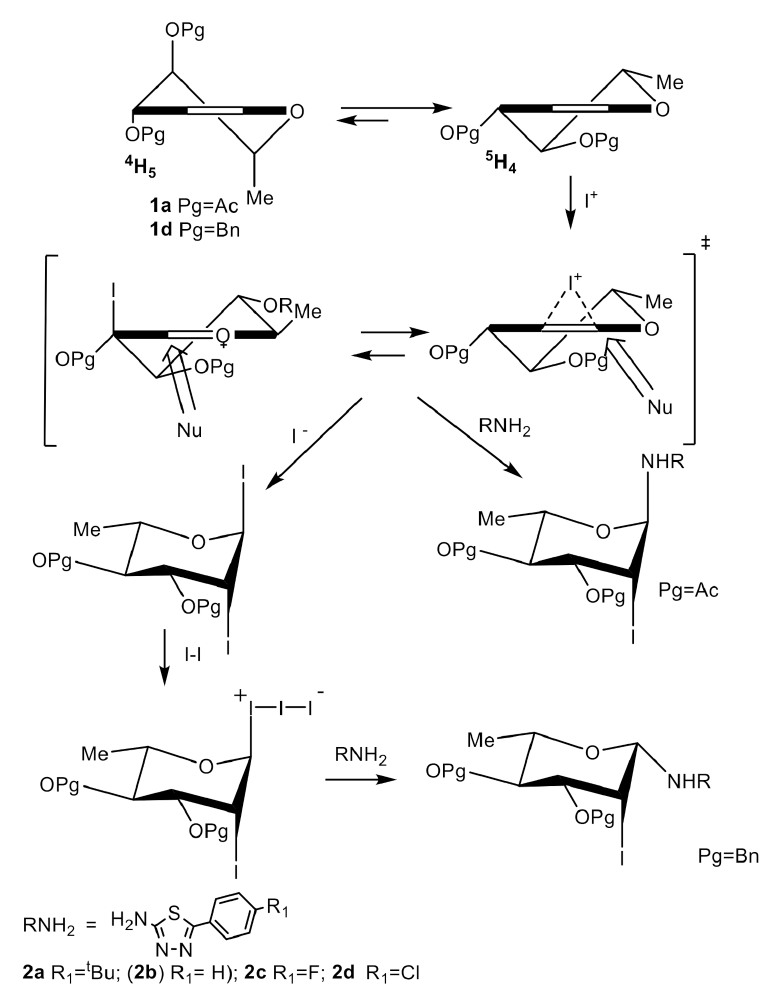
Scheme 3. Synthesis of 2-amino-1,3,4-thiadiazole glycosides starting from L-rhamnal ( 1a ) with stereochemical